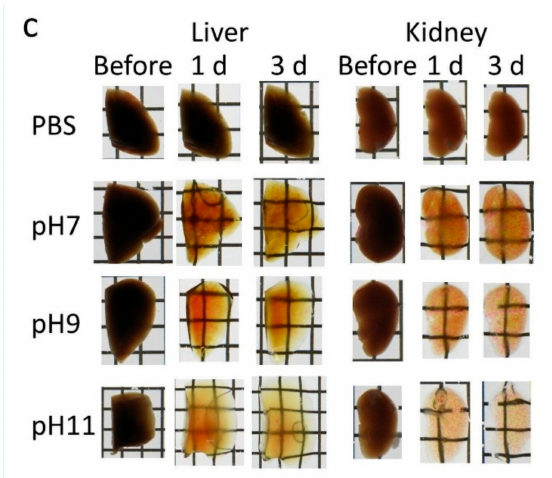
Figure 1. Tissue clearing using Seebest. ( a ) Murine liver and kidney cleared by polyethylenimine (PEI) solutions (molecular weight, MW 1800; 10, 20, and 50 w / v %). ( b ) Clearing speed of Seebest. DiI-perfused liver and kidney were cleared using Seebest [pH 11, PEI (MW 1800) 20 w / v % + 8 M urea]. ( c ) The pH dependency of tissue clearing using Seebest. DiI-perfused liver and kidney were cleared using Seebest [pH 7, 9, and 11, PEI (MW 600) 10 w / v % + PEI (MW 10,000) 10 w / v % + 8 M urea]. Each lattice was 4 mm wide and 4 mm high. Each image was representative of at least three